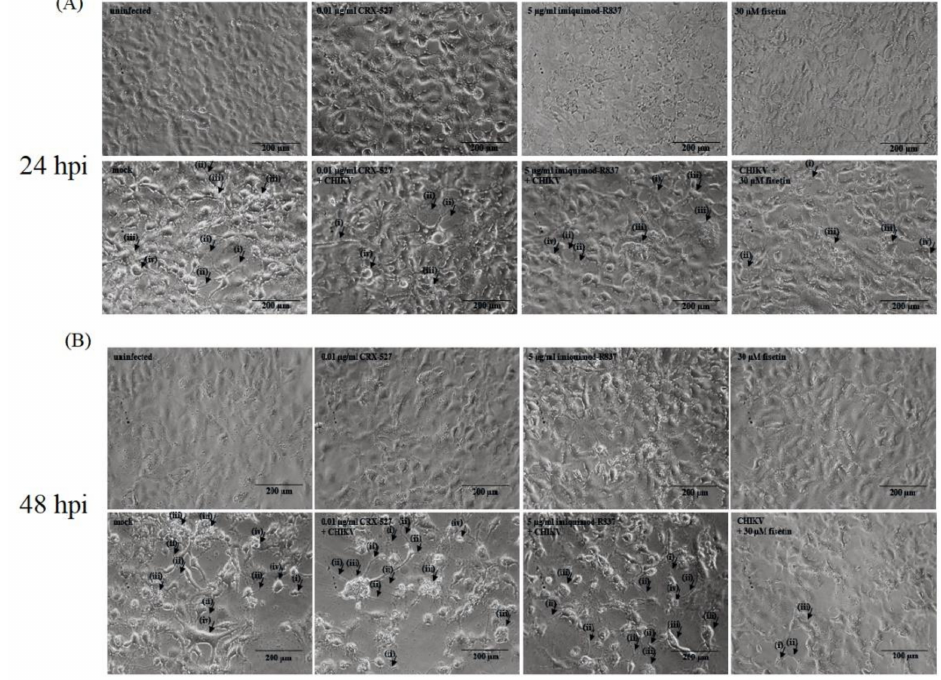
Figure 2. Bright-field microscopic examination (at 20 × ) of CHIKV-induced morphological changes. ( A ) 24 hpi and ( B ) 48 hpi in order to the left of the row; uninfected, CRX-527-treated, imiquimod- R837-treated, and fisetin-treated, with the top column being uninfected Huh7 cells and bottom as mock Huh7 cells. CHIKV infection was performed using MOI = 1. Labeled in the figures are: (i) cell shrinkage; (ii) detached and convoluted extension; (iii) increase of cell membrane protrusion; and (iv) plasma membrane